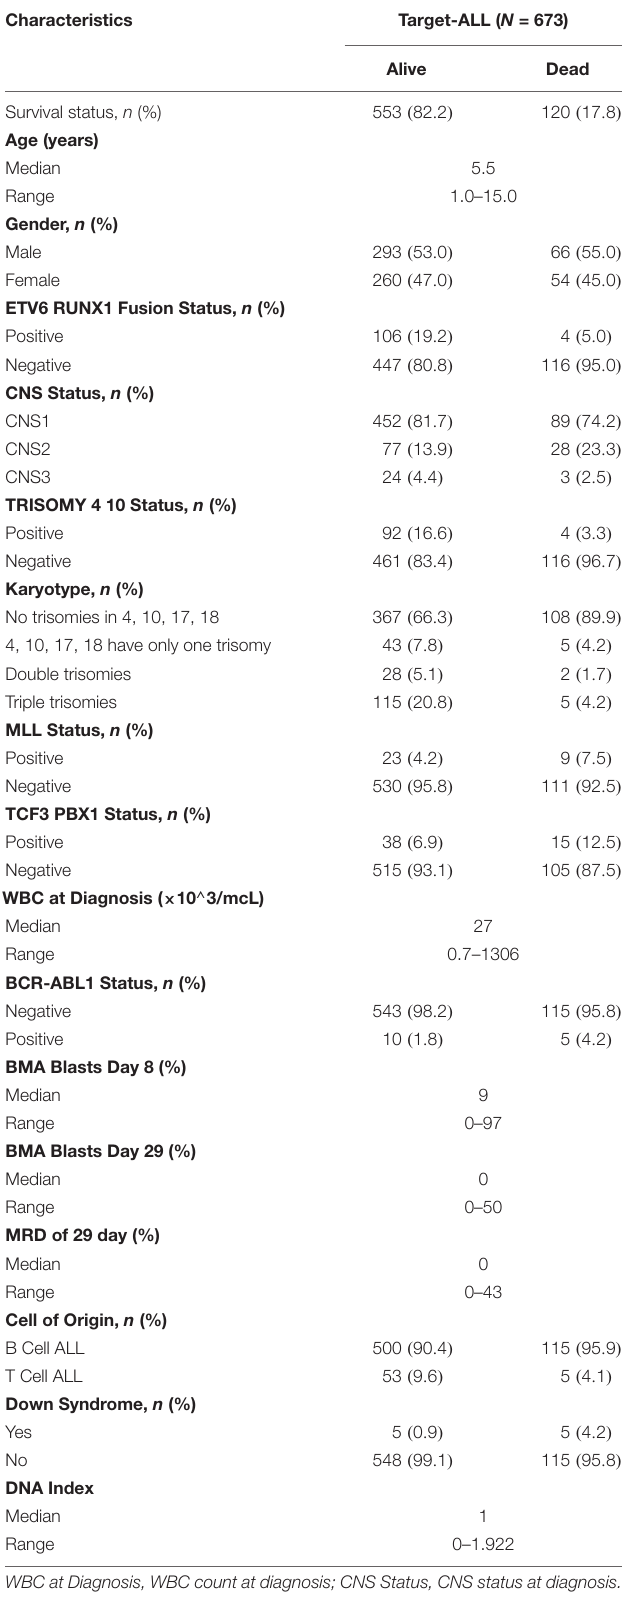
TABLE 1 | The clinicopathological characteristics of patients in the cohort.